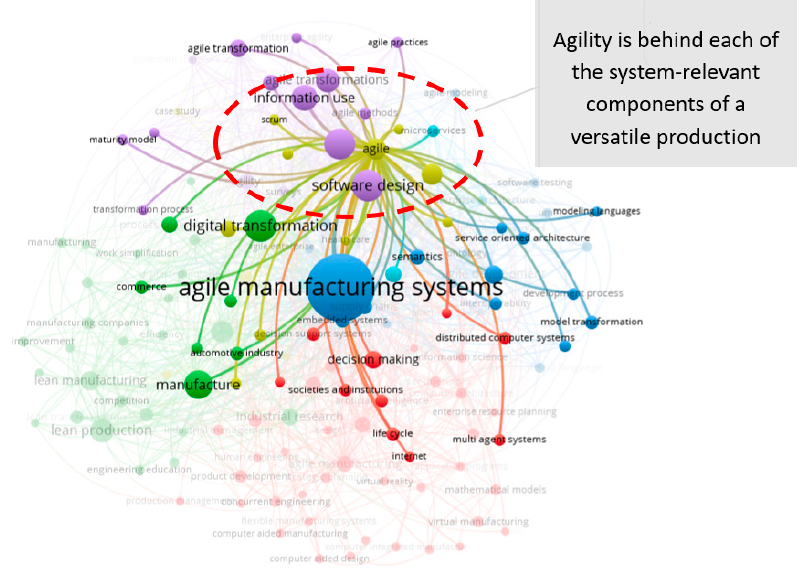
Figure 9. Focus ‐ oriented evaluation results in ‘agile hardware and software design’. Figure 9. Focus-oriented evaluation results in ‘agile hardware and software